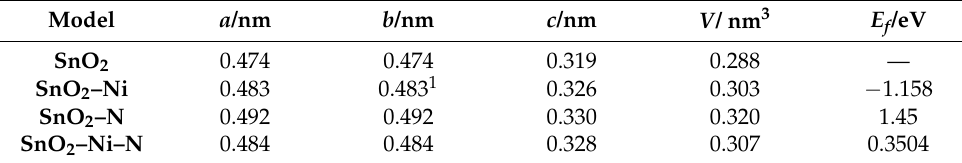
Table 1. Lattice constants and doping formation